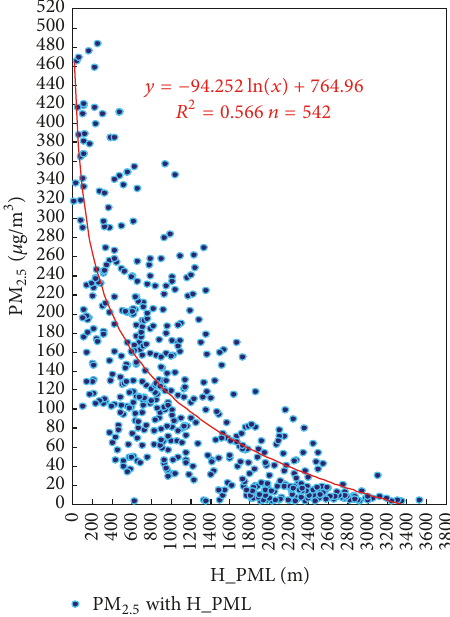
data in Beijing in the period of 1–31 December 2016. Totally,